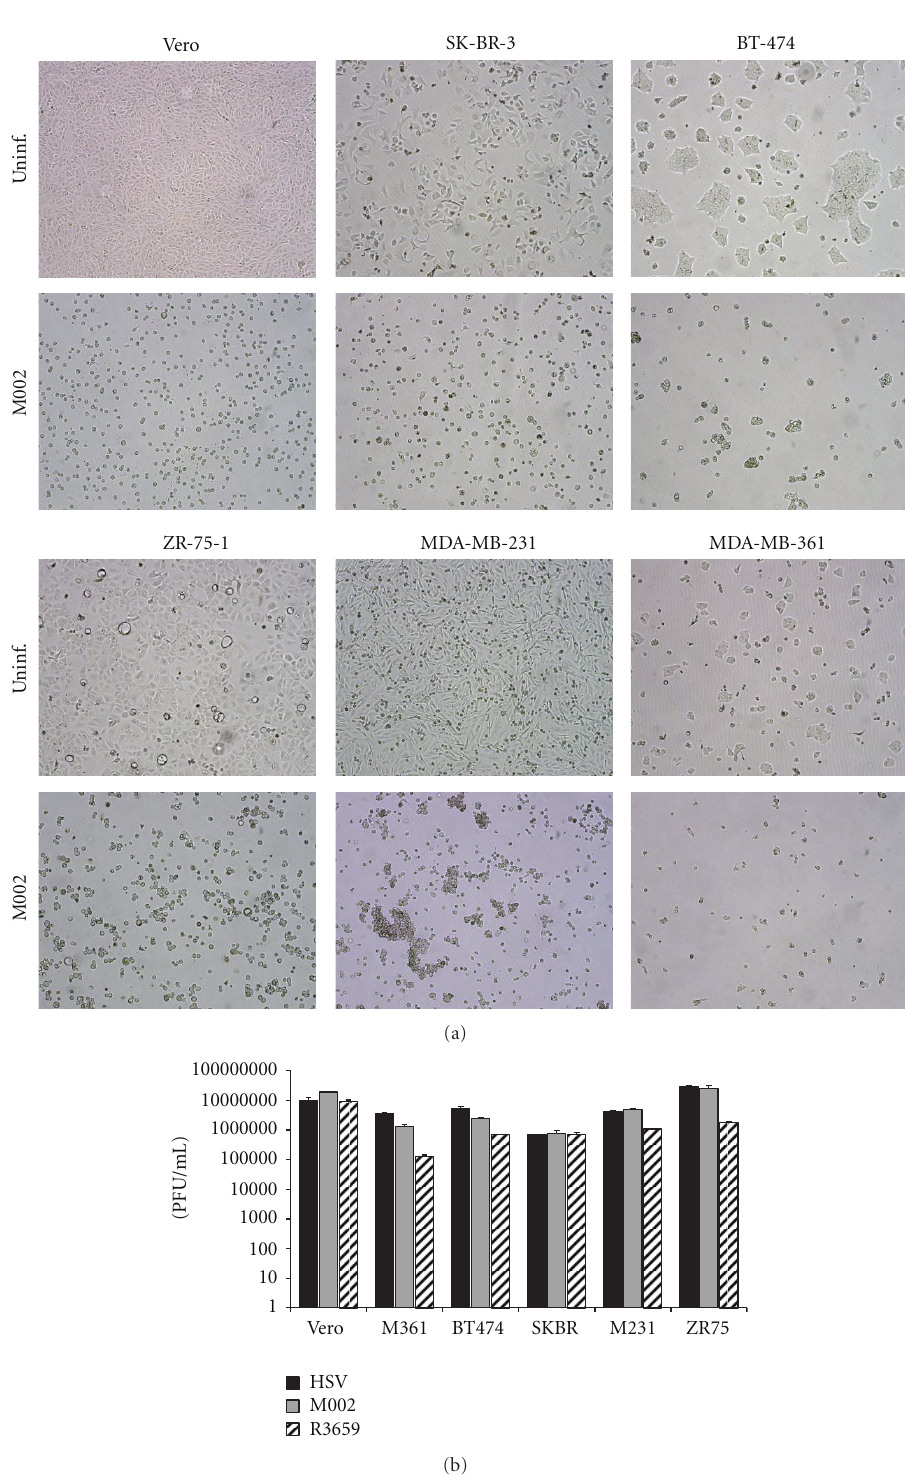
Figure 2: A panel of cell lines including permissive Vero cells and 5 human breast cancer cell lines, MDA-MB-361 (M361), BT-474, SK-BR-3 (SKBR), MDA-MB-231 (M231), and ZR-75-1 (ZR75) were infected with M002 at an MOI of 5 PFU/cell. (a) Bright-field photomicrographs (100x magnification) of viral cytopathic e ff ect mediated by M002 in the infected cells shown in comparison with healthy uninfected cells. The cytopathic e ff ect mediated by HSV-1 (F) and R3659 (not shown) were identical to M002. (b) Replication of wild-type HSV-1 (F), IL- 12-expressing HSV M002, or the non-cytokine-expressing control virus R3659 in a panel of human breast cancer cells at 48 h post-infection. Shown are the averages and standard deviations of duplicate determinations, from a representative of three